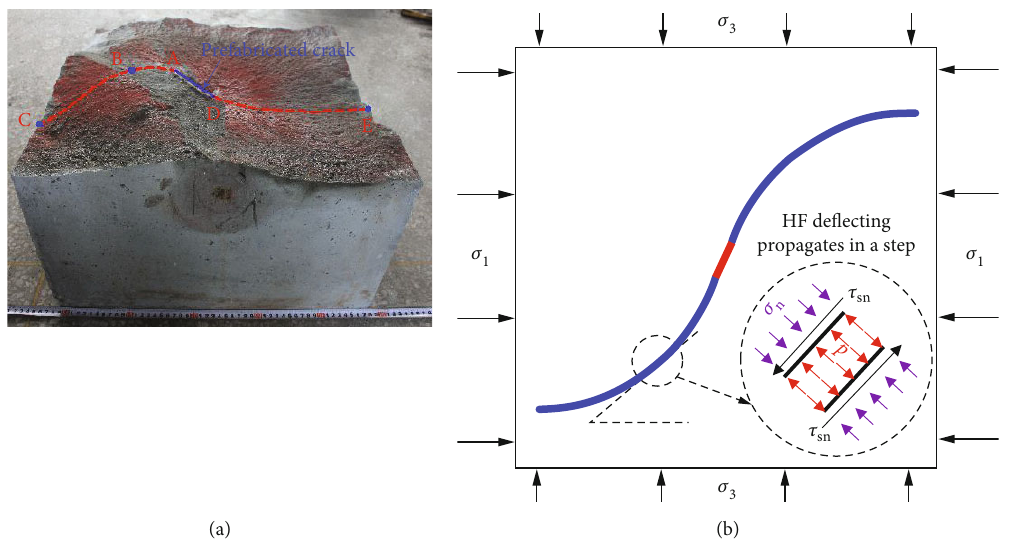
Figure 1: The photo and diagram of the de fl ecting hydraulic fracture: (a) photos of the HF de fl ecting propagation with hydraulic fracturing physical simulation tests (our previous work); (b) the diagram of de fl ecting HF bearing tensile and shear